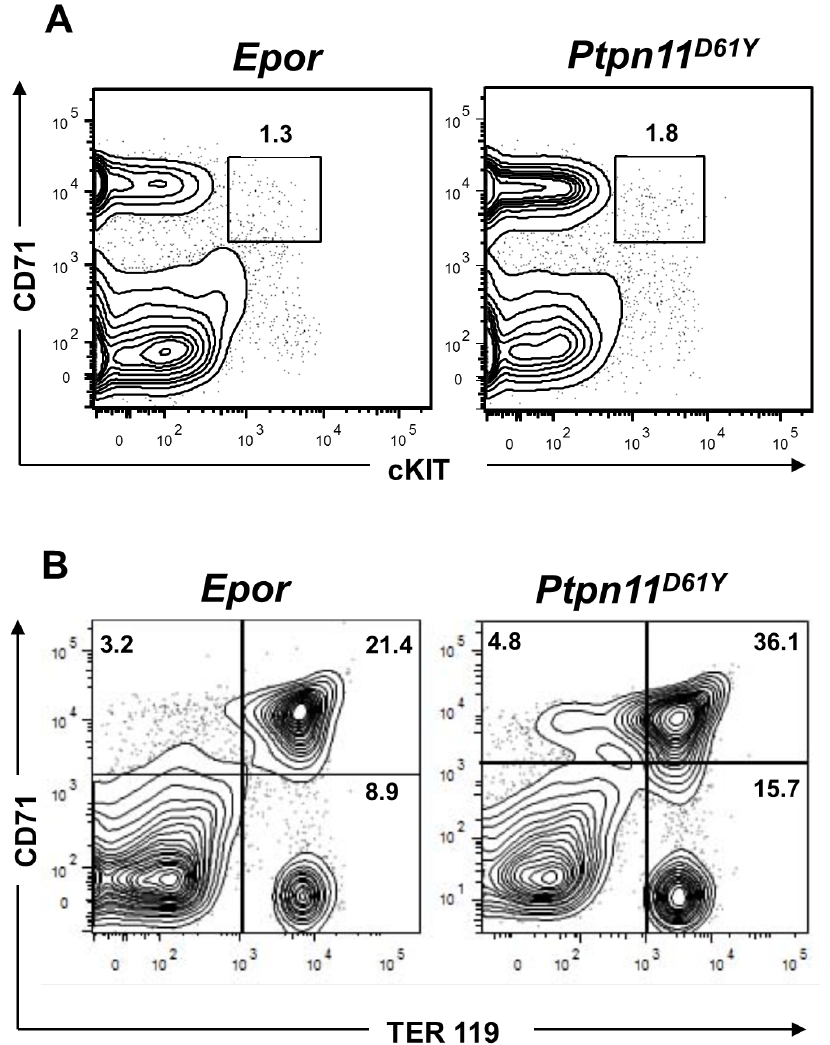
Figure 3. Altered erythroid differentiation of Ptpn11 D61Y mice. (A, B) Representative flow cytometry profiles of BM cells from Epor and Ptpn11 D61Y mice. Erythroid subsets include EP (cKIT + CD71 + Ter119 2 ) (A), and Pro EB (cKIT l u CD71 + TER119 2 ) and Early EB (CD71 + TER119 + ) (B). See Table 2 for frequencies and absolute numbers of each population.